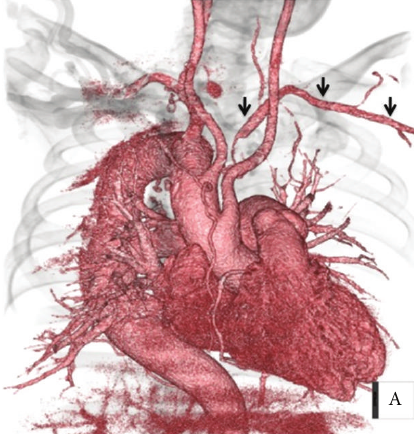
Figure 3: Postoperative CT revealed enhanced ALSA (arrows) clearly without delay, which was supplied with blood from many branches through very narrow and invisible collateral